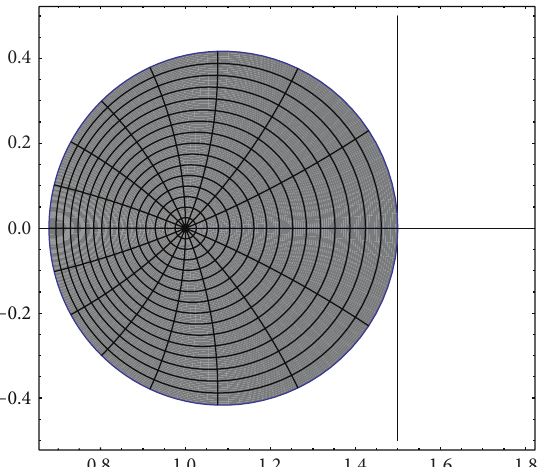
Figure 3: Image of |𝑧| ≤ (4 − √13)/3 touches Re 𝑤 = 1.5 .